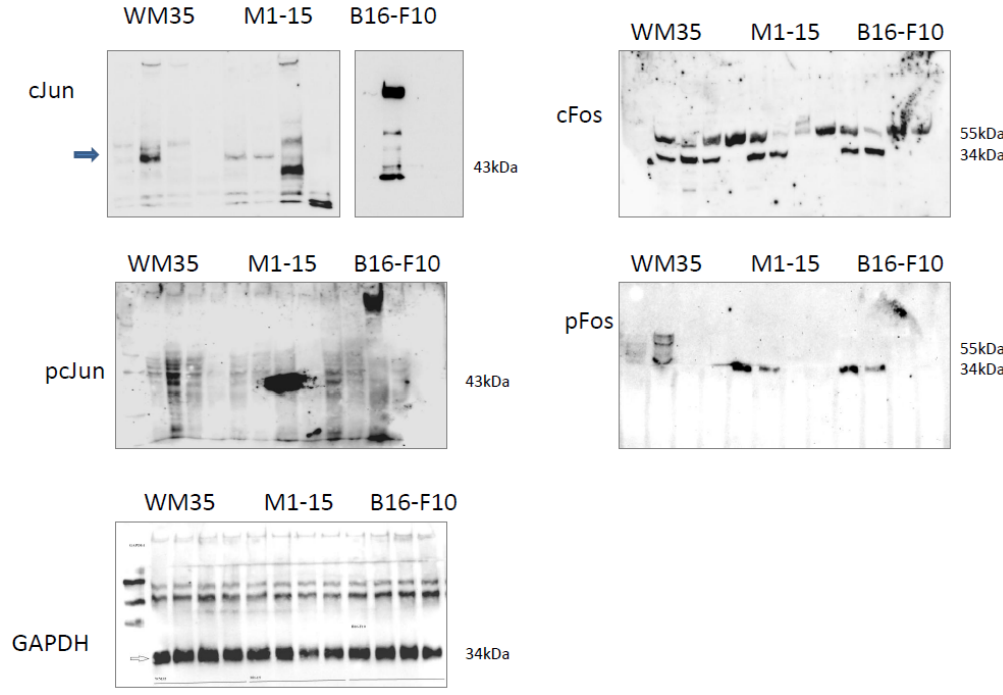
Figure A4. Original images WB Figure 8.